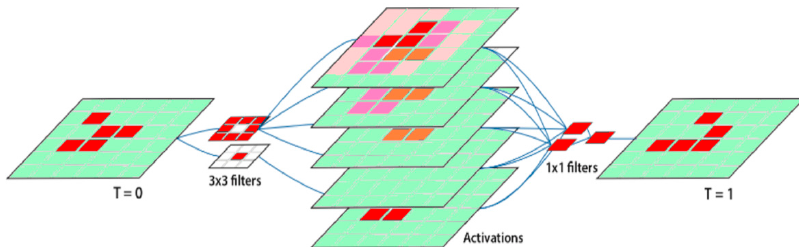
Figure 2. Conway’s Game of Life as a convolutional neural network. Two convolutional filters identify the value of the center pixel and count the number of neighbors. These features are then scored and summed to generate a prediction for the system at the next time point.